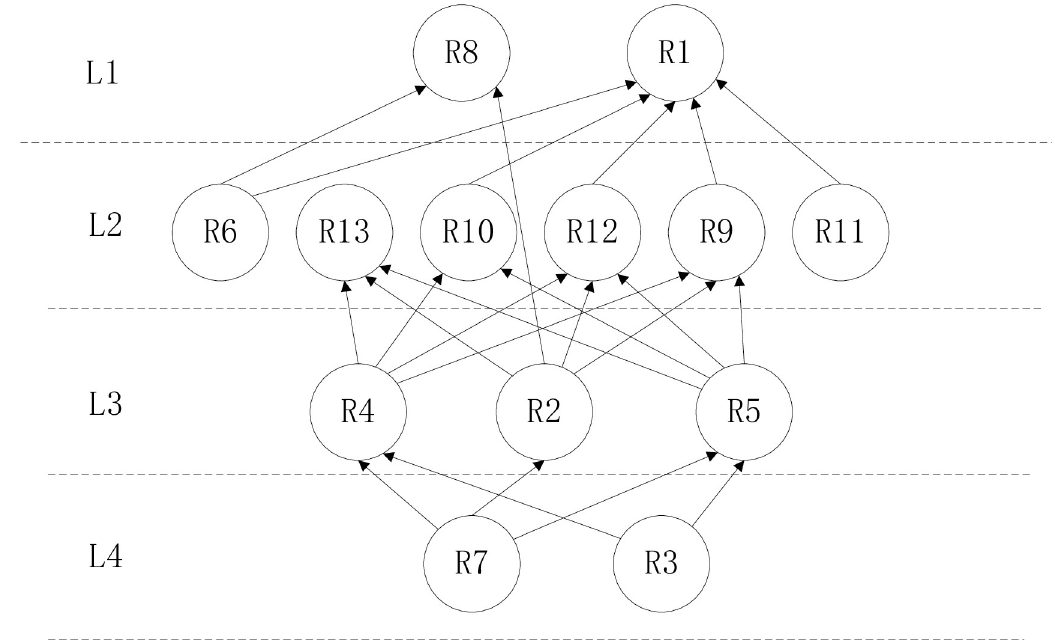
Fig 1. The ISM results for the risk factors of fresh agricultural product